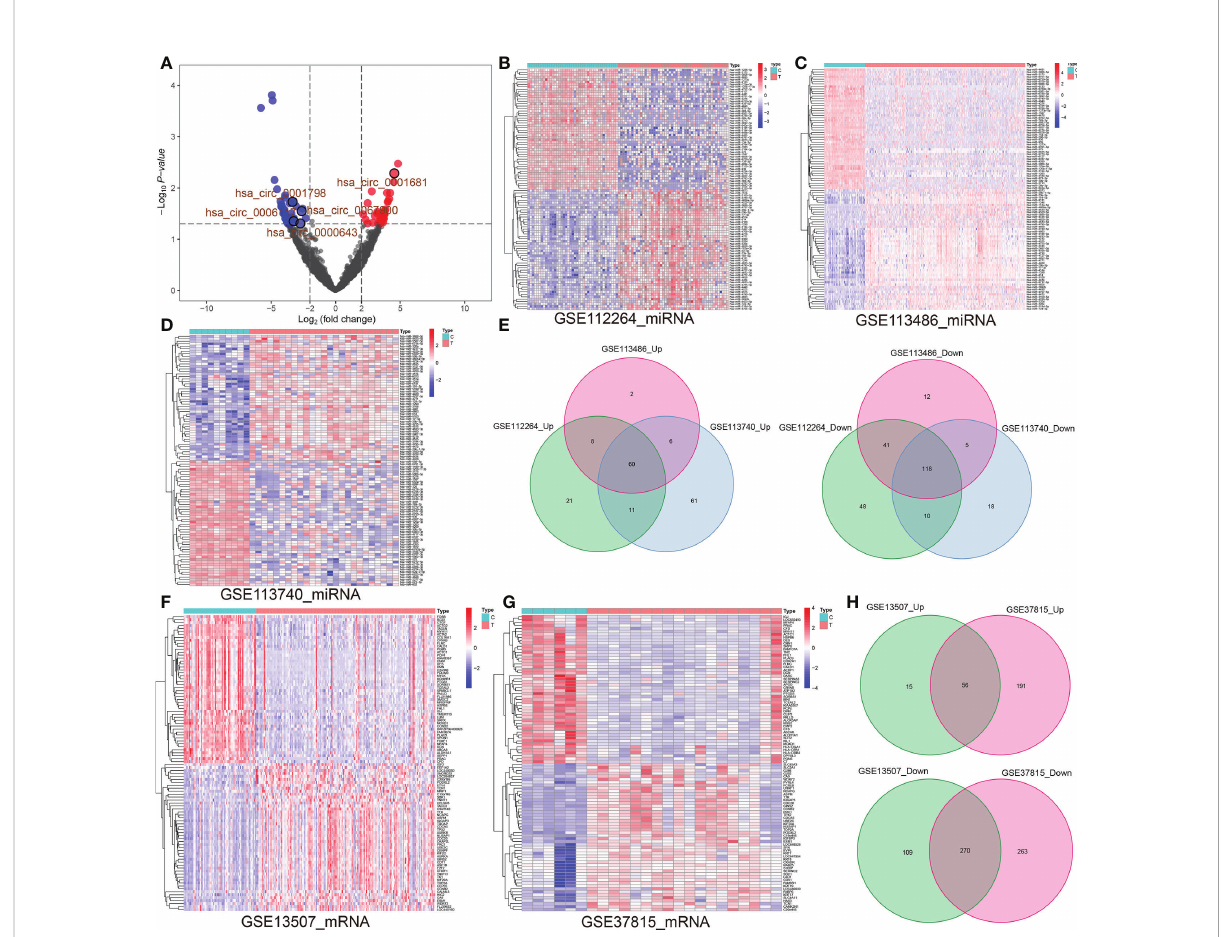
FIGURE 1 (A) Volcano map representing the up-regulated and down-regulated circRNAs in BCa vs. para-carcinoma tissues (log2(FC) ≥ 2 or ≤ -2; P< 0.05). (B – D) Based on GSE11224, GSE113786 and GSE113740 datasets, top 50 up-regulated and top 50 down-regulated miRNAs in BCa tissues vs. controls were shown. (E) Venn diagrams revealed the number of overlapping up-regulated (left) or down-regulated (right) miRNAs among GSE11224, GSE113786 and GSE113740. (F, G) Based on two datasets (GSE13507 and GSE37815), top 50 up-regulated and top 50 down- regulated miRNAs in BCa tissues vs. controls were exhibited. (H) Venn diagrams represent overlapping up or down-regulated genes between GSE13507 and GSE37815 datasets. circRNA, circular RNA; miRNA, microRNA; BCa, bladder cancer; FC, fold